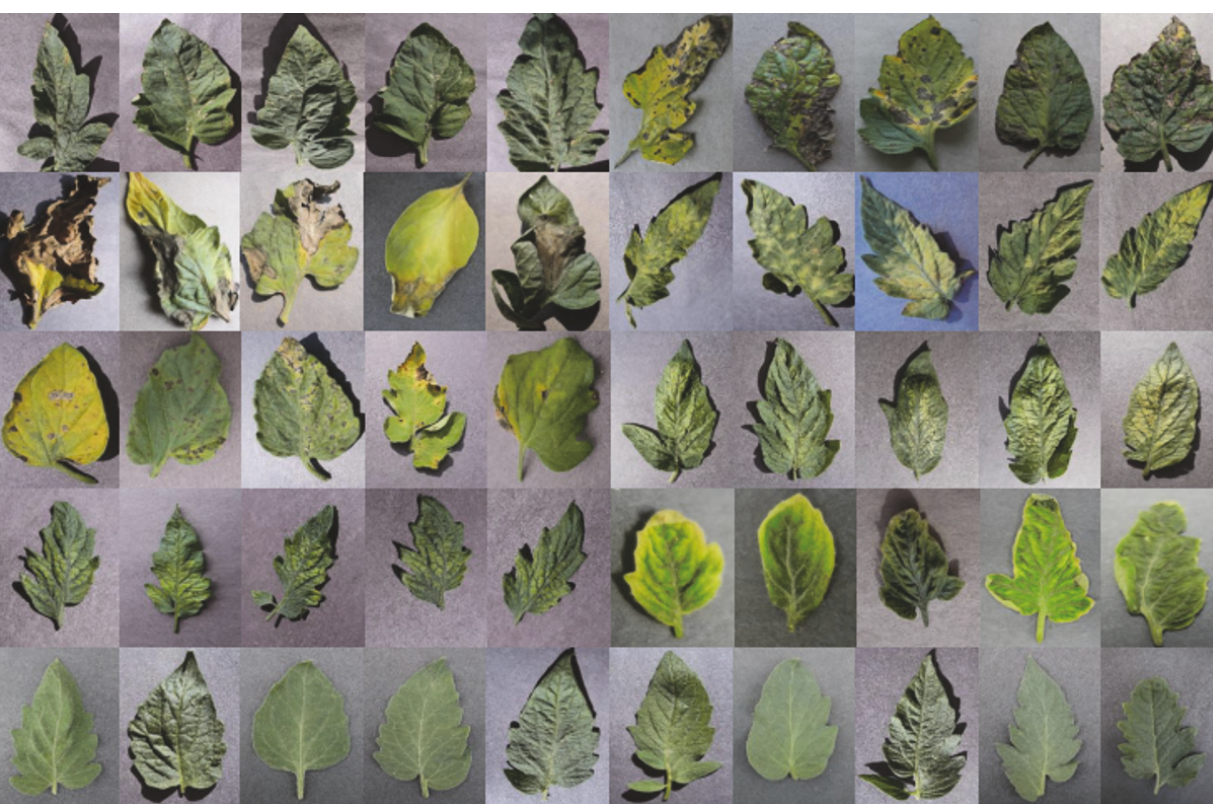
Figure 2: Raw tomato leaf